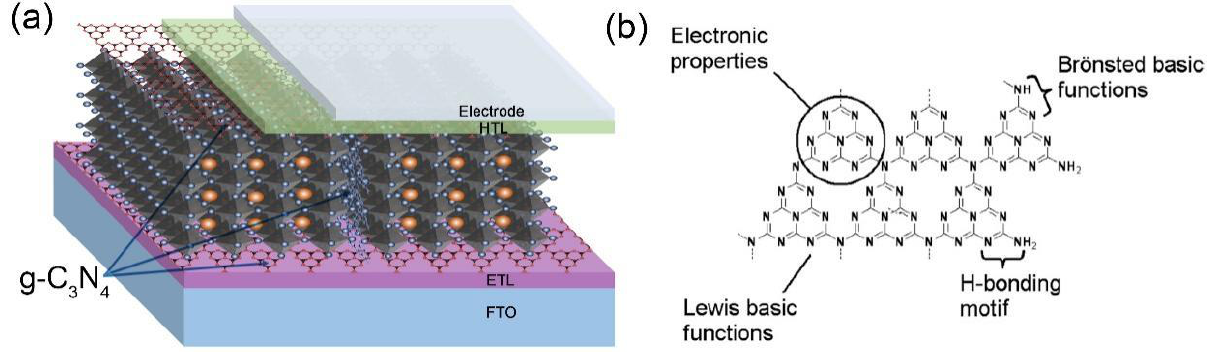
Figure 1. ( a ) g-C 3 N 4 as an additive or interface engineering material in PSCs, ( b ) surface groups and properties of tri-s-triazine-based g-C 3 N 4 (reproduced with permission [42]; copyright 2020, American Chemical Society).